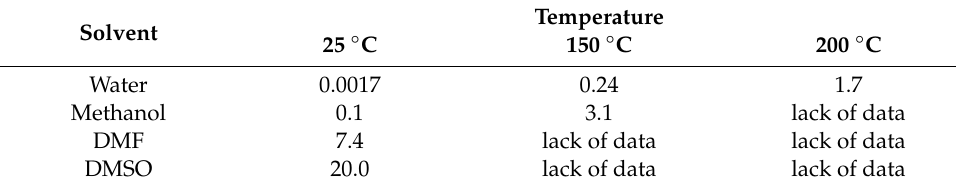
Table 1. Solubility of PTA (terephthalic acid) in organic solvents (g PTA / 100 g solvent) [1].